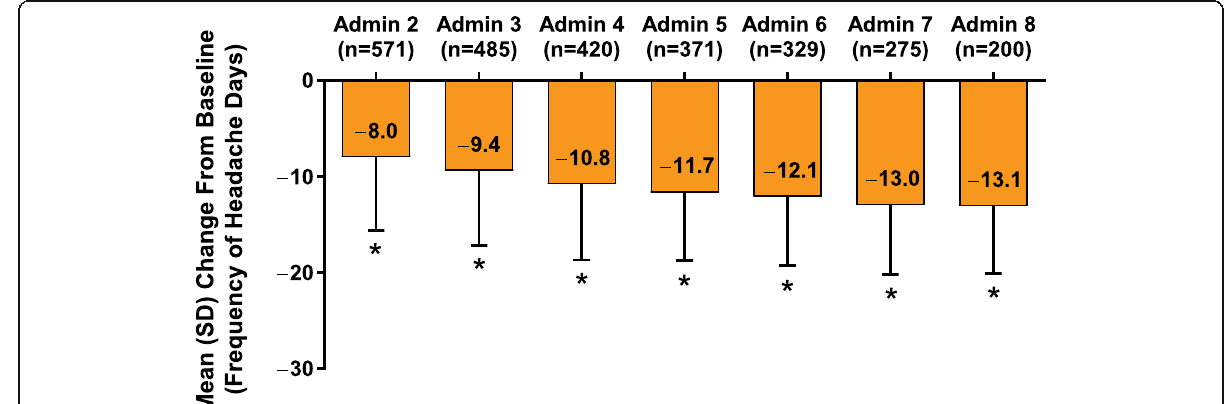
Fig. 1 Mean change from baseline in frequency of headache days. Patient-reported estimate of number of days in a month with a headache ( ≥ 4 h) at each administration visit through visit 8. † Mean (SD) headache-day frequency at baseline was 20.6 (5.4) days per month. * P < 0.001 Wilcoxon signed rank test for change versus baseline (level of significance: 5%). † The numbers of patients in administration (Admin) visits 9 – 13 were as follows: Admin 9, n = 119; Admin 10, n = 50; Admin 11, n = 24; Admin 12, n = 13; Admin 13, n = 7. Mean changes from baseline for Admin visits 9 – 13 were each significant (Admin 9 – 12, P < 0.001; Admin 13, P = 0.016)